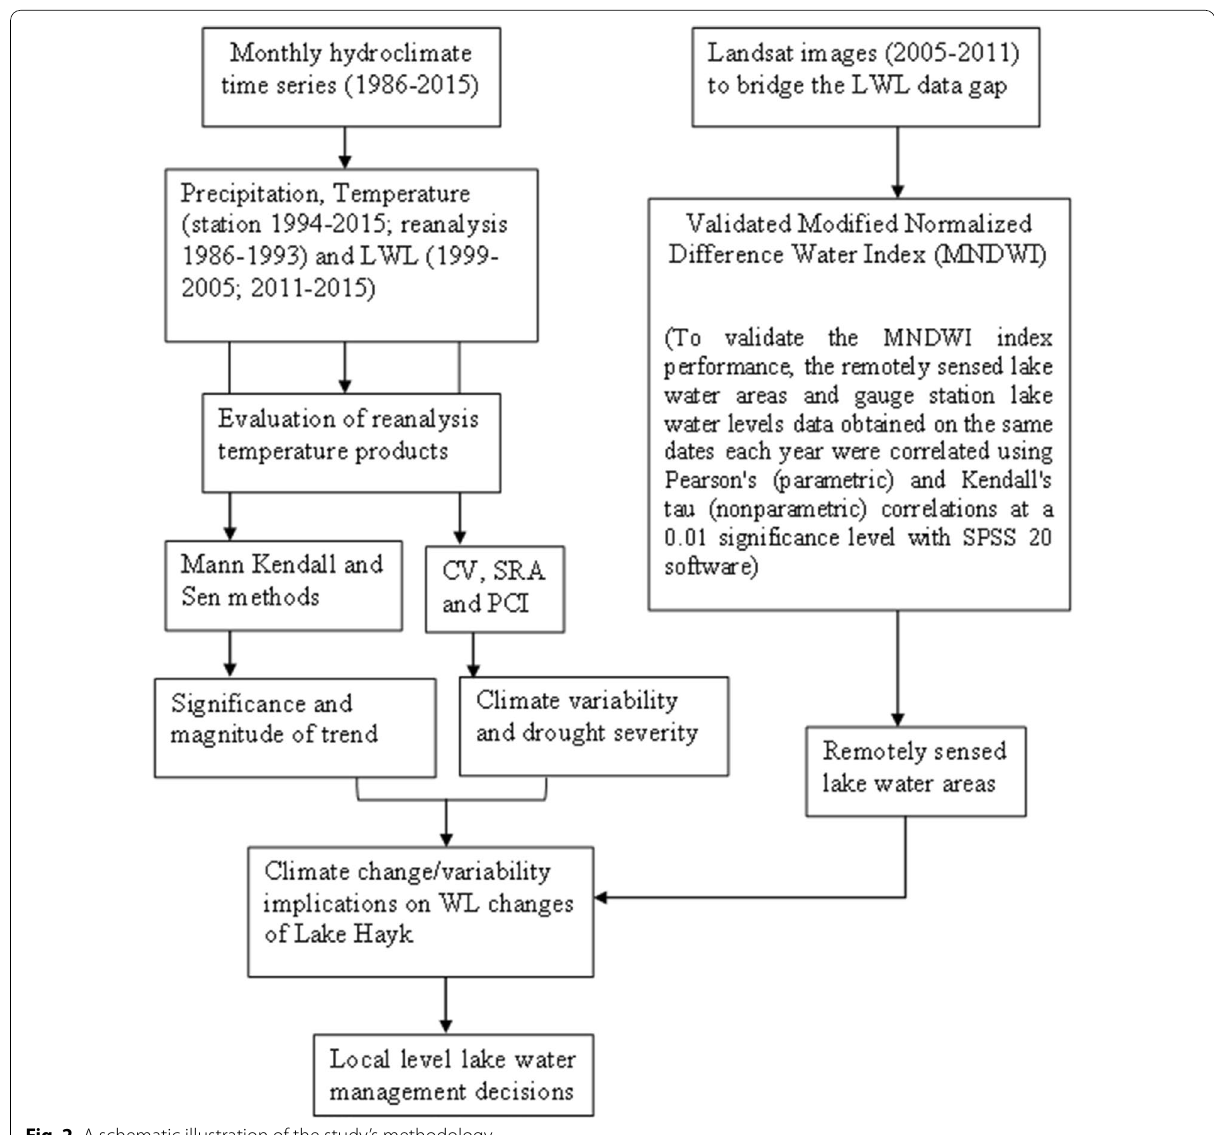
Fig. 2 A schematic illustration of the study’s